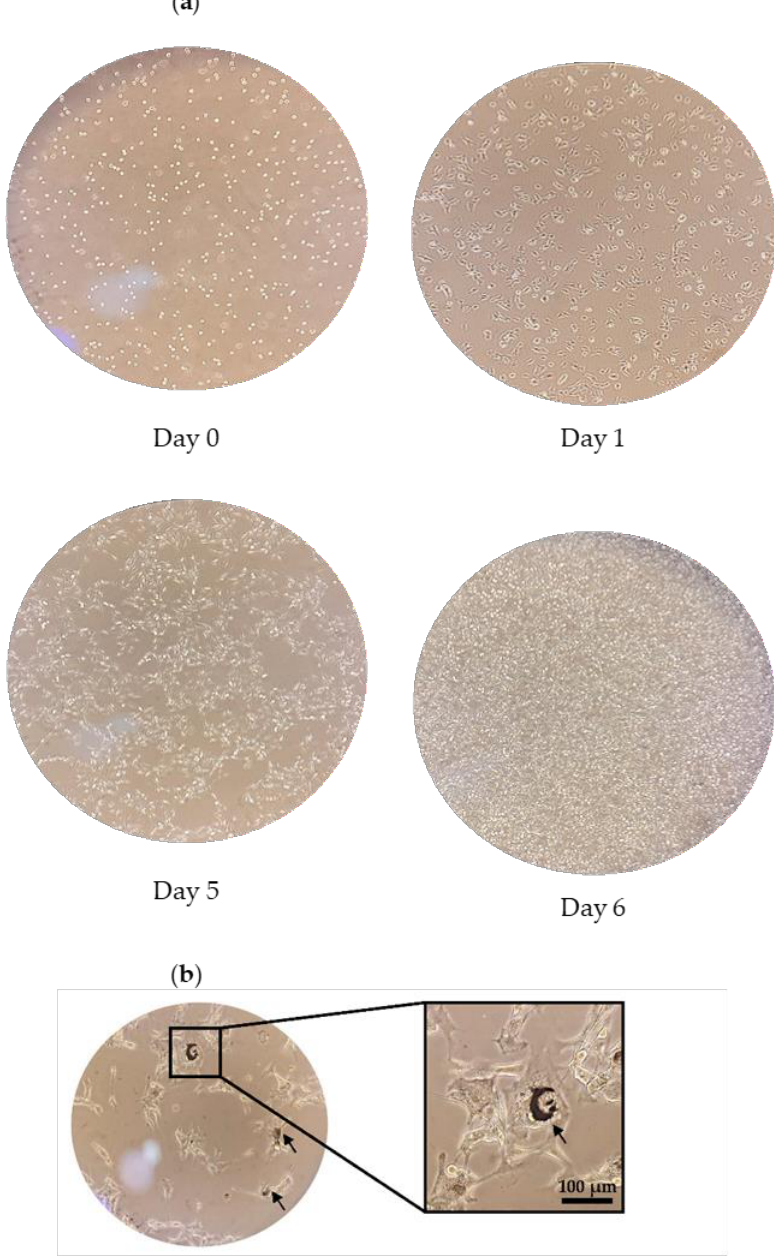
Figure 1. The ( a ) growth morphology of B16F10 melanoma cells viewed under 100 × magnification and ( b ) melanin deposition (black arrows) viewed under 200 × magnification.